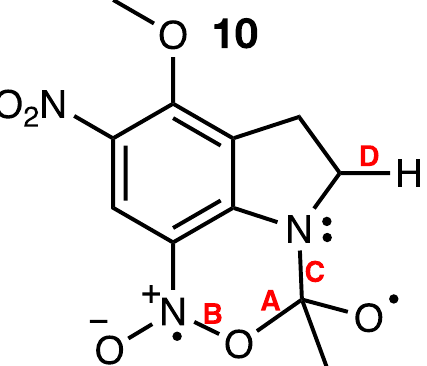
Figure 3. The cyclic intermediate for MDNI-Ac. This structure is similar to structure 5 in Fig. 1, but instead of glutamate, it is bound to acetate.